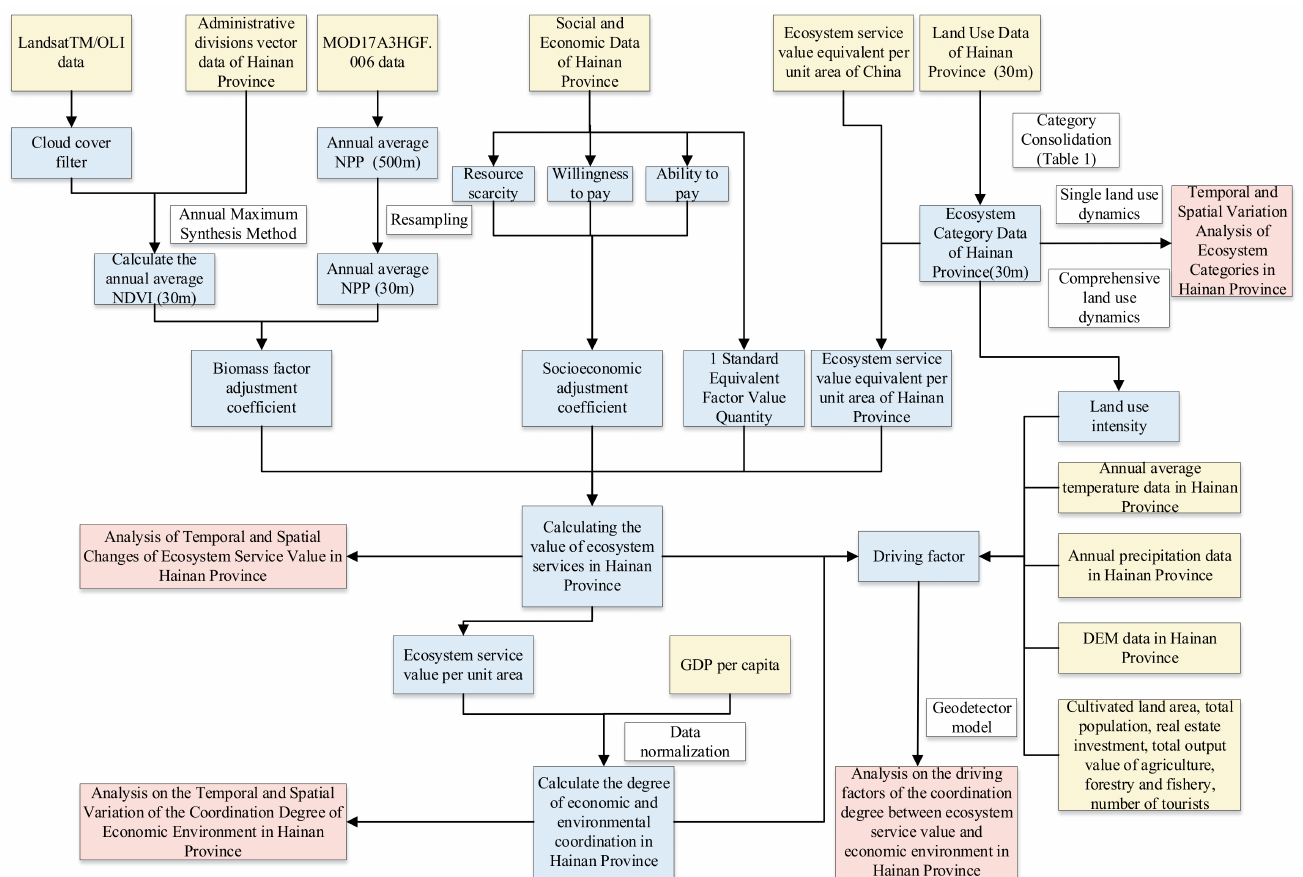
Figure 2. Technology roadmap for computational and driving force analysis of ESV and